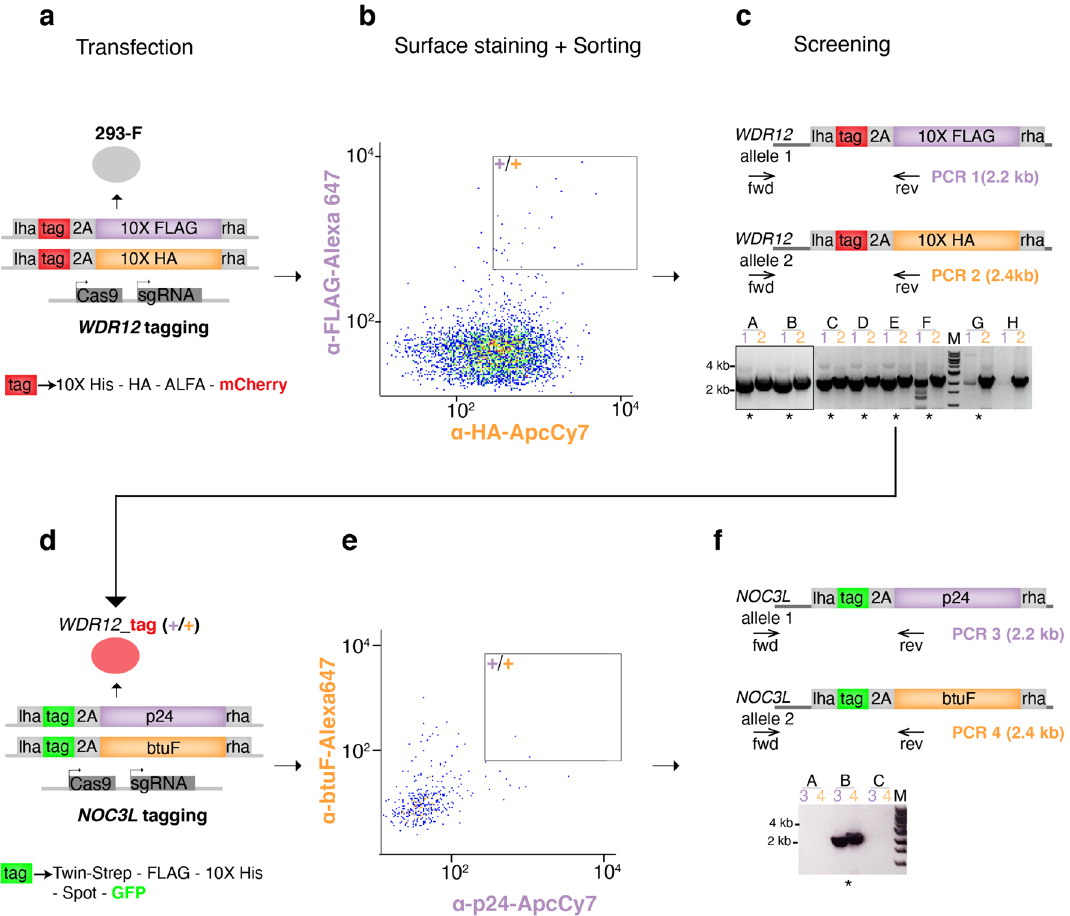
Figure 2. Iterative biallelic tagging using SNEAK PEEC. Biallelic tagging of the WDR12 gene using SNEAK PEEC ( a – c ). Transfection of 293-F cells with knock-in plasmids for biallelic C-terminal tagging ( a ). Surface staining of the transfected cell population with fluorescent antibodies targeting both surface displays (10X FLAG, 10X HA) ( b ). FACS sort of tagged mCherry positive single cell clones that also stain for both display targeting fluorescent antibodies (black box) ( b ). Genomic screening PCRs to identify biallelically edited clones (clones A-H) ( c ). Clones positive for both PCR products are indicated by asterisks. A single clone (clone E) was expanded for biallelic tagging of the NOC3L gene using a new set of knock-in plasmids ( d ). Surface staining of the transfected cell population with fluorescent nanobodies targeting both new surface displays (p24, btuF 23,24 ). FACS sort of mCherry/GFP positive single cell clones that stain for both display targeting nanobodies (black box) ( e ). Genomic screening PCRs to identify biallelically edited clones (clones A-C) ( f ). Gel images shown in ( c ) and ( f ) have been cropped. Original gel images are shown in supplementary Fig.